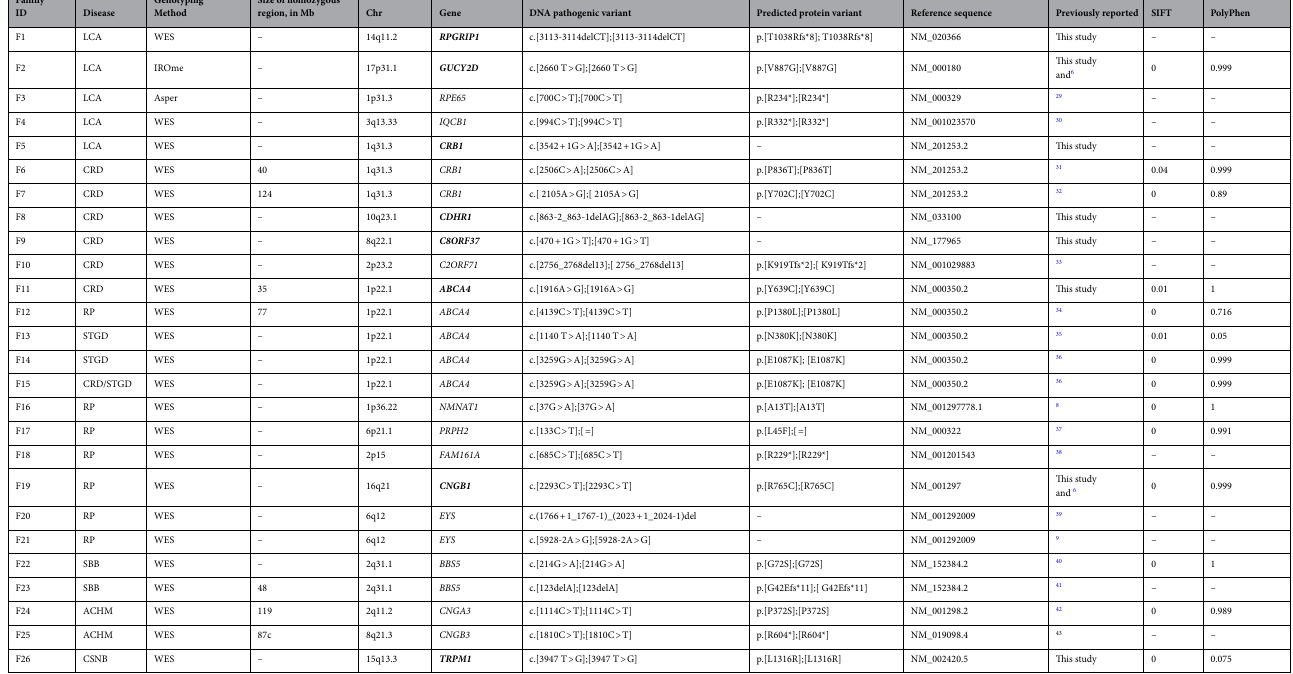
Table 1. Pathogenic variants identified in this study. Genes highlighted in bold harbor the novel pathogenic variants identified in this study. LCA = Leber congenital amaurosis; RP = retinitis pigmentosa; CRD = cone- rod dystrophy; STGD = Stargardt disease; BBS = Bardet–Biedl syndrome; ACHM = Achromatopsia; CSNB = congenital stationary night